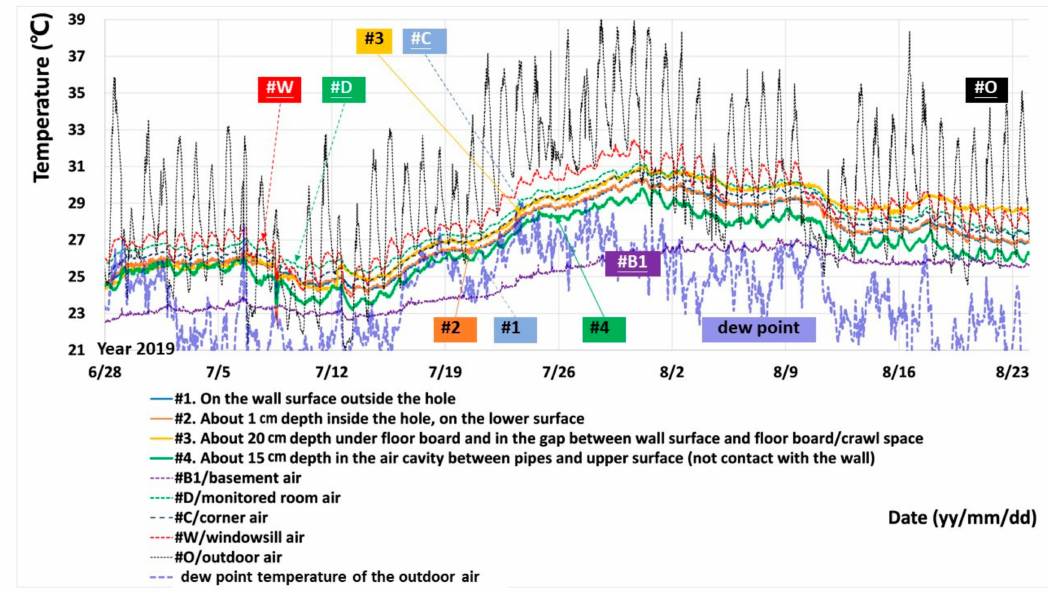
Figure 14. The temperatures around the air cavity (28 June–23 August 2019).